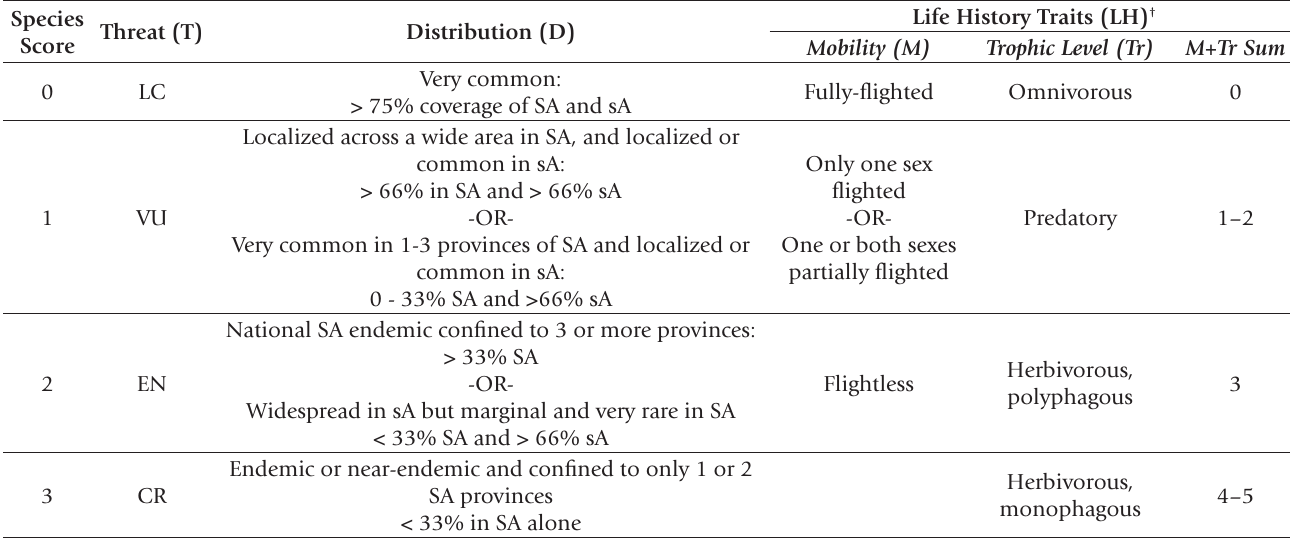
Table 1. Katydid Biotic Index calculation